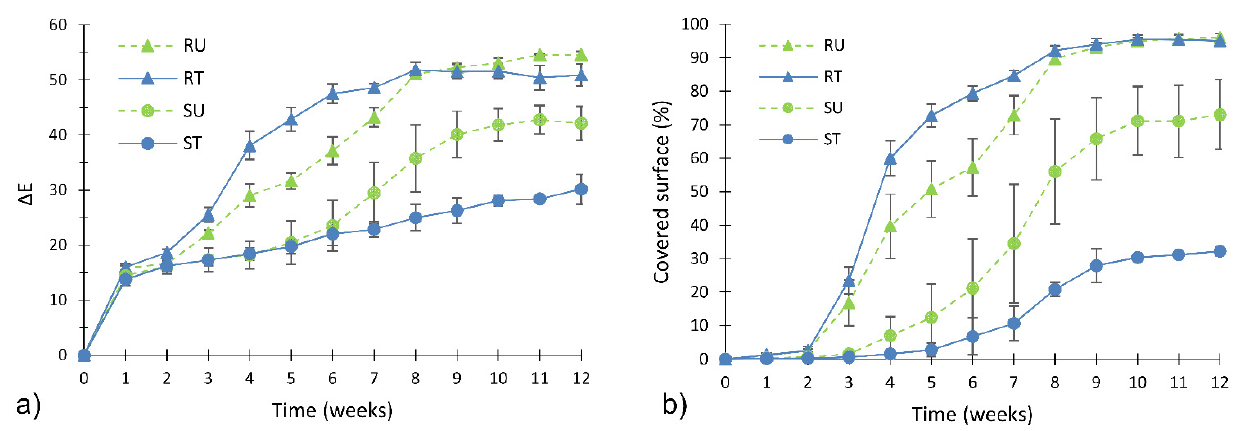
Figure 5. Extent of algal fouling evaluated by colorimetric analysis ( a ) and DIA ( b ) during the accelerated fouling